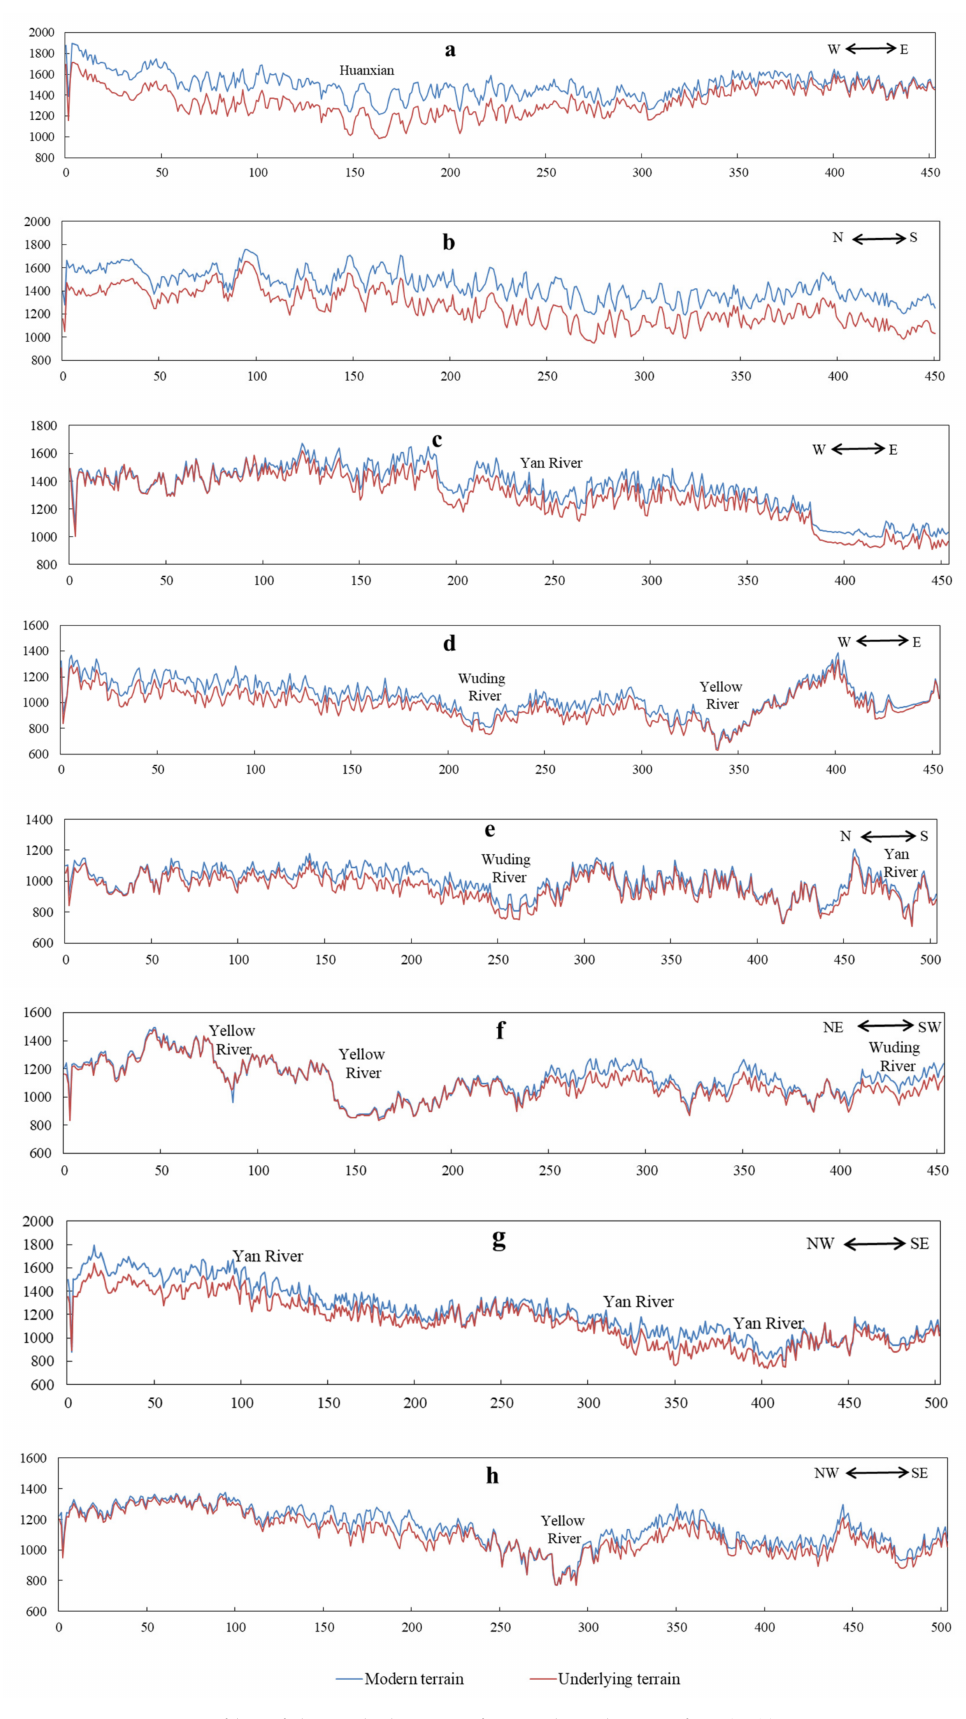
Figure 13. Terrain profiles of the underlying surface and modern surface ( a – h